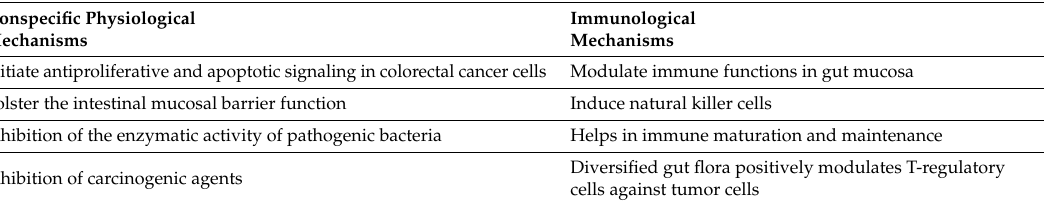
Table 3. Mechanisms the probiotics can have on the